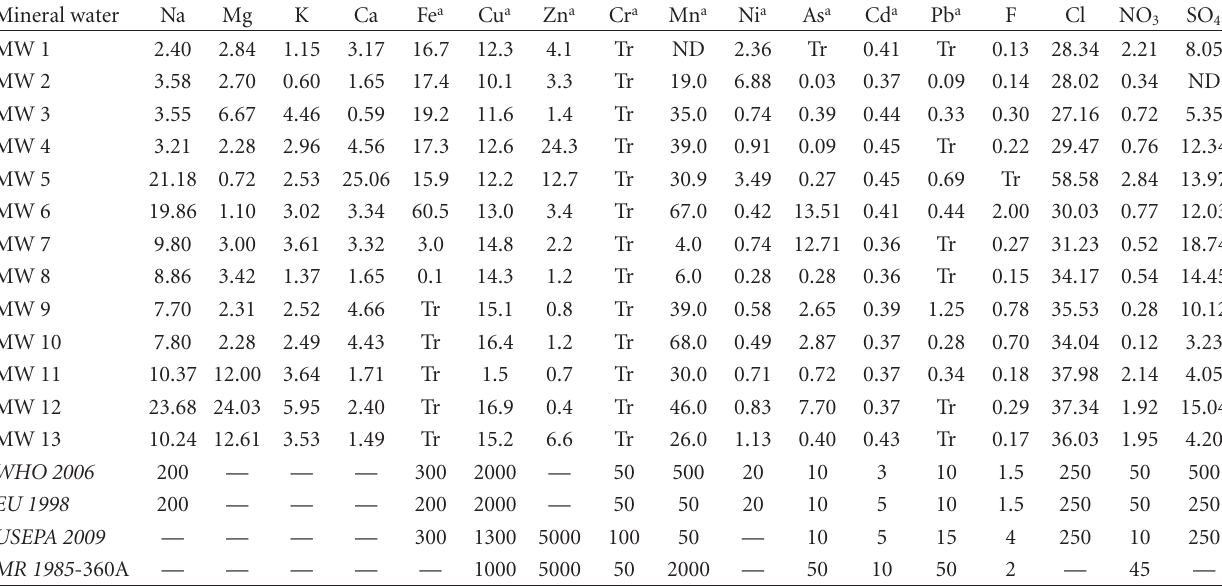
Table 3: Mineral concentrations in mineral water (MW) samples and the standard limits recommended by Malaysian Food Regulations and international